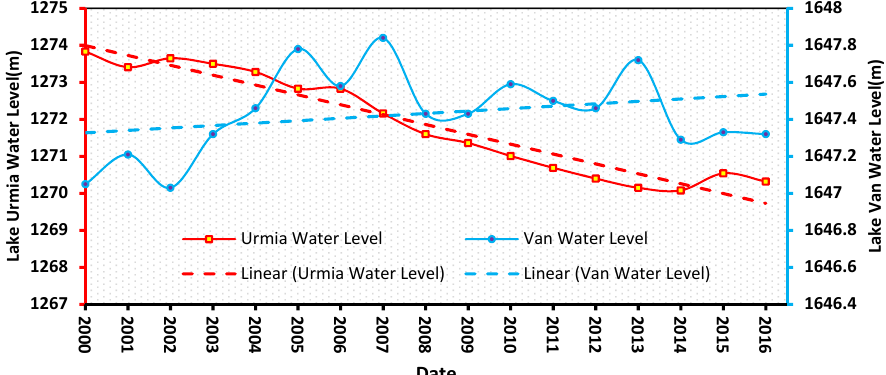
Figure 5. Annual changes in water levels in LU and LV and the trend in its changes for the 17-year period 2000 to 2016 based on [25]. The general decrease in the surface area of LU by the annual maps of the surface area from 2000 to 2016 is shown in Figure 6, and the rather constant surface area of LV during the same period is illustrated in Figure 7. As shown in Figure 6, the surface area at the southern shore of LU was the first to recede, followed by the surface area at the eastern and then the northern shores. The surface area along the western shore was the least sensitive to recession. The average surface area of LU from 2000 to 2016 was approximately 3138 km 2 , with maximum surface areas of 4666, 4624, and 4496 km 2 recorded in 2000 (Figure 6), 2001, and 2003, respectively. The corresponding average surface area of LV was approximately 3579 km 2 , with maximum surface areas of 3598, 3590, and 3589 km 2 recorded in 2004, 2000, and 2010, respectively (Figure 7). Minimum water surface areas for LU were approximately 700 and 800 km 2 and were recorded in September 2014 (Figure 6) and 2015, respectively.